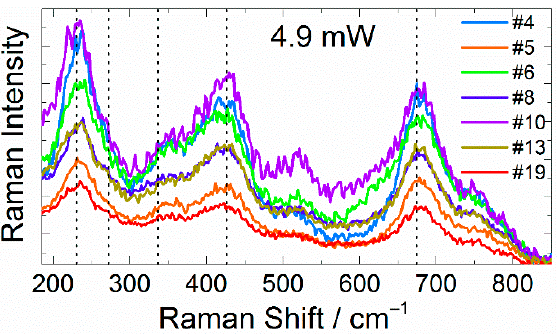
Figure 1. Raman spectra of seven individual particles. The dotted lines indicate the positions of the main characteristic LTO bands. Probing laser power: 4.9 mW.